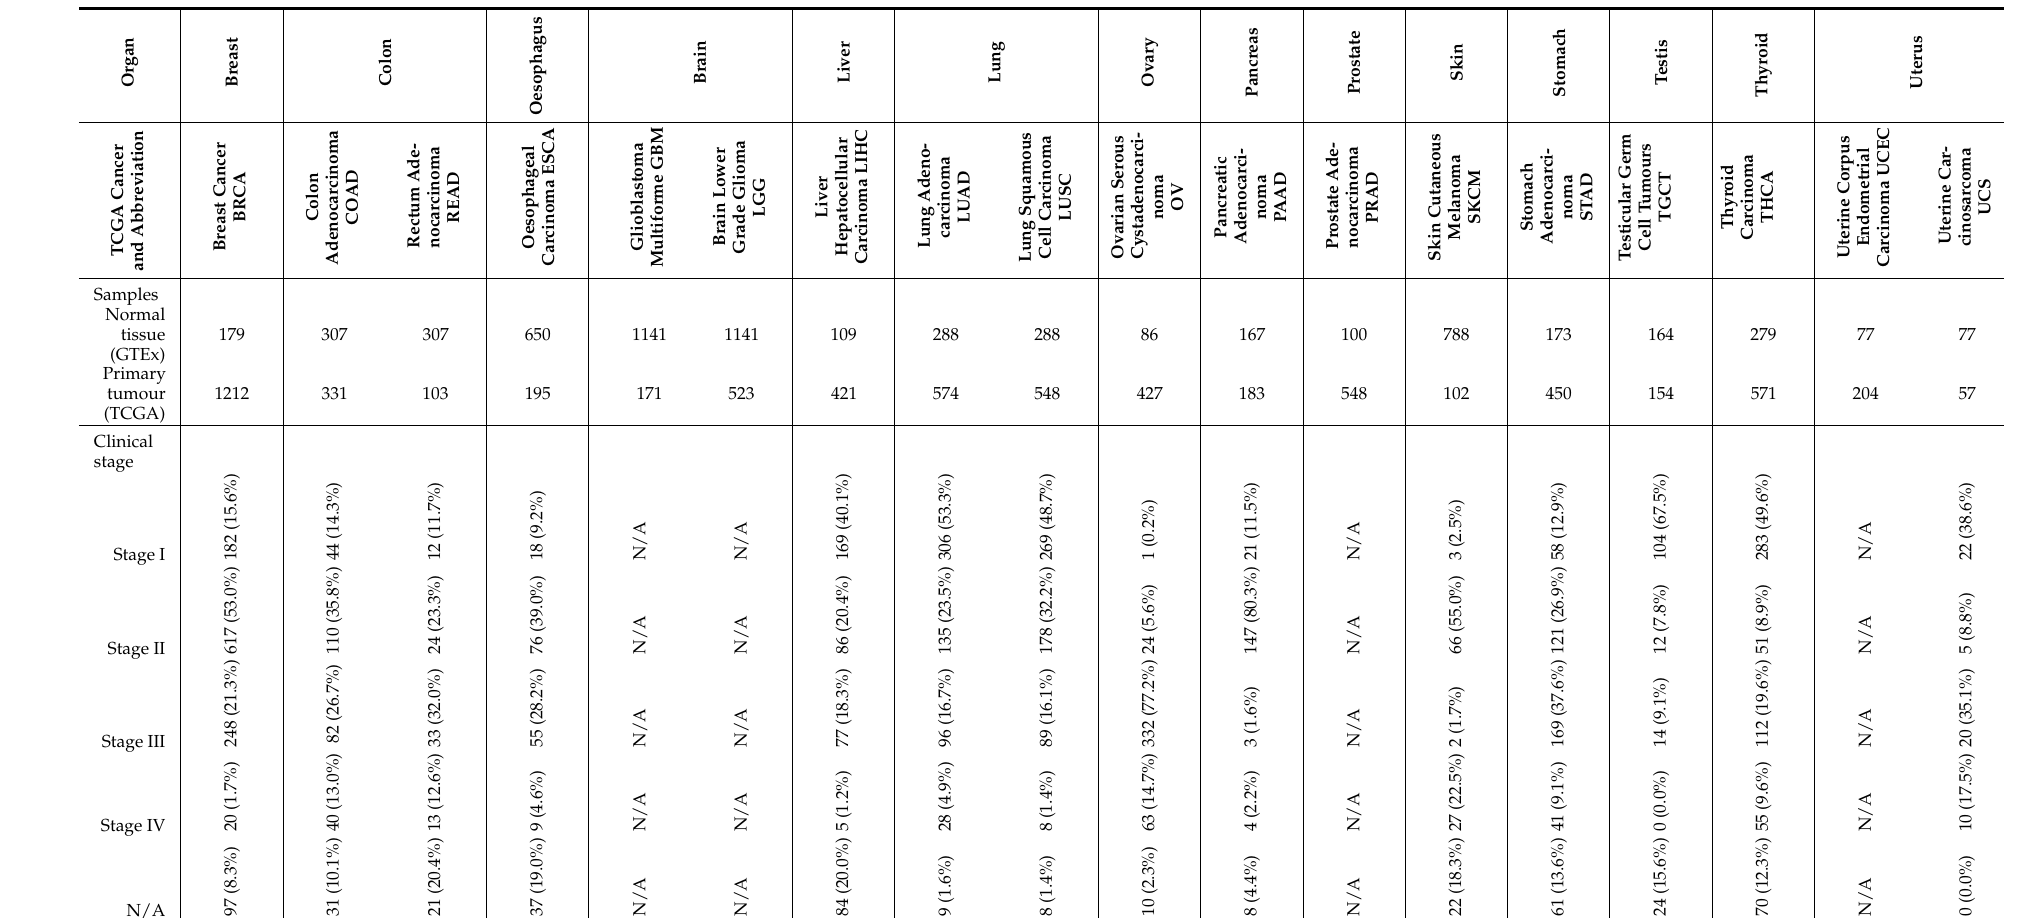
Table 1. Clinical details of TCGA and GTEx